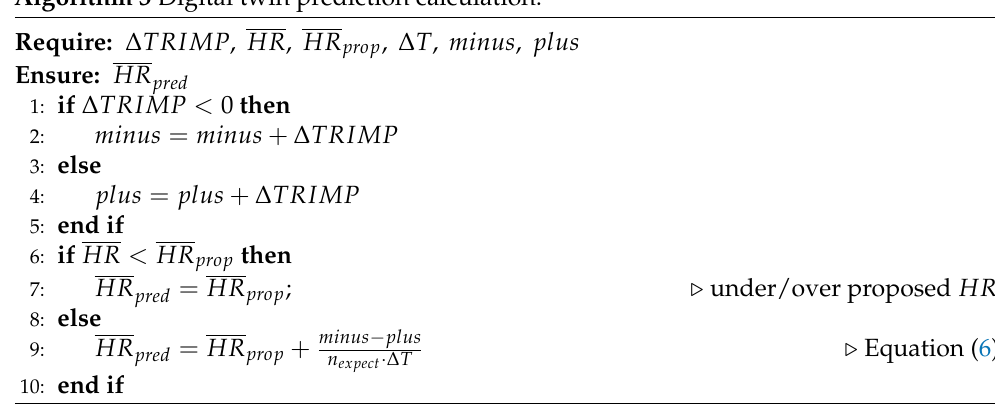
Algorithm 3 Digital twin prediction calculation.